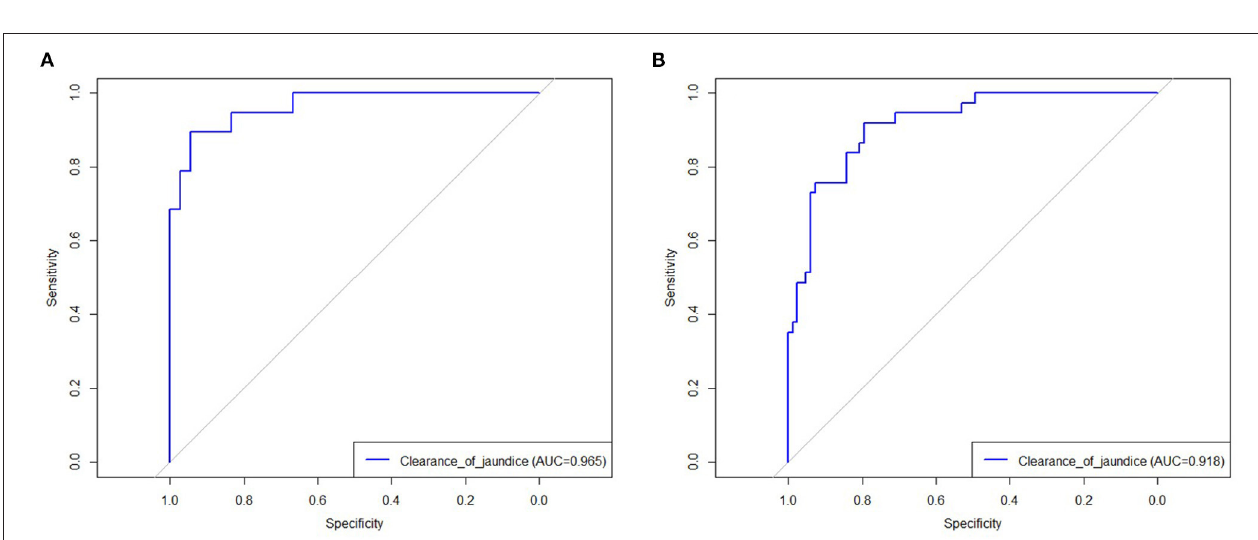
FIGURE 2 | The nomogram for prediction the possibility of unsuccessful CJ in patients with KP. (Each clinical factor with different status would correspond to a score in “Point”. The scores for each clinical factor were added to obtain an overall score in “Total point”. Then, “Total point” would correspond to risk of “Probability of unsuccessful CJ”.) CMV, cytomegalovirus; GGT, γ -glutamyl transpeptidase; LSM, liver stiffness measurement; CJ, clearance of jaundice; BA, biliary atresia; KP, Kasai procedure.